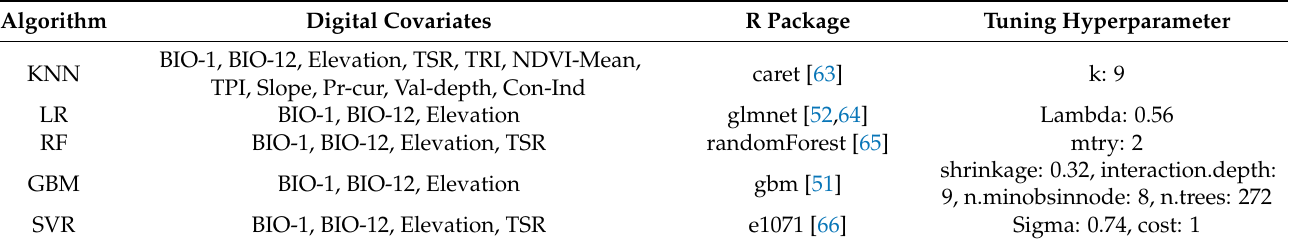
Table 2. Parameters of the machine learning algorithms used and final digital covariates included to model